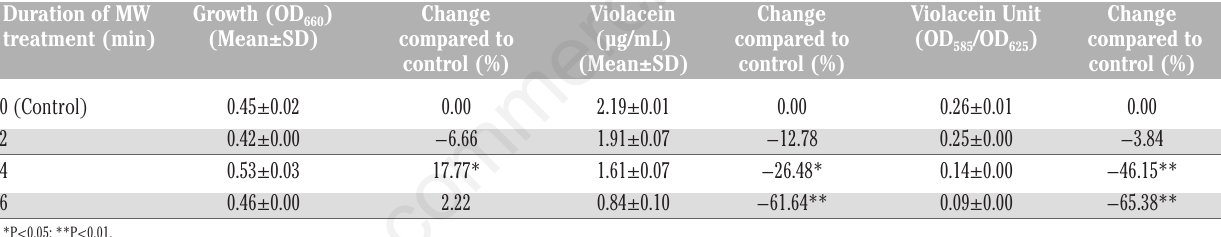
Table 1. Effect of low power microwaves (MW) on growth and violacein production in C. violaceum. Duration of MW